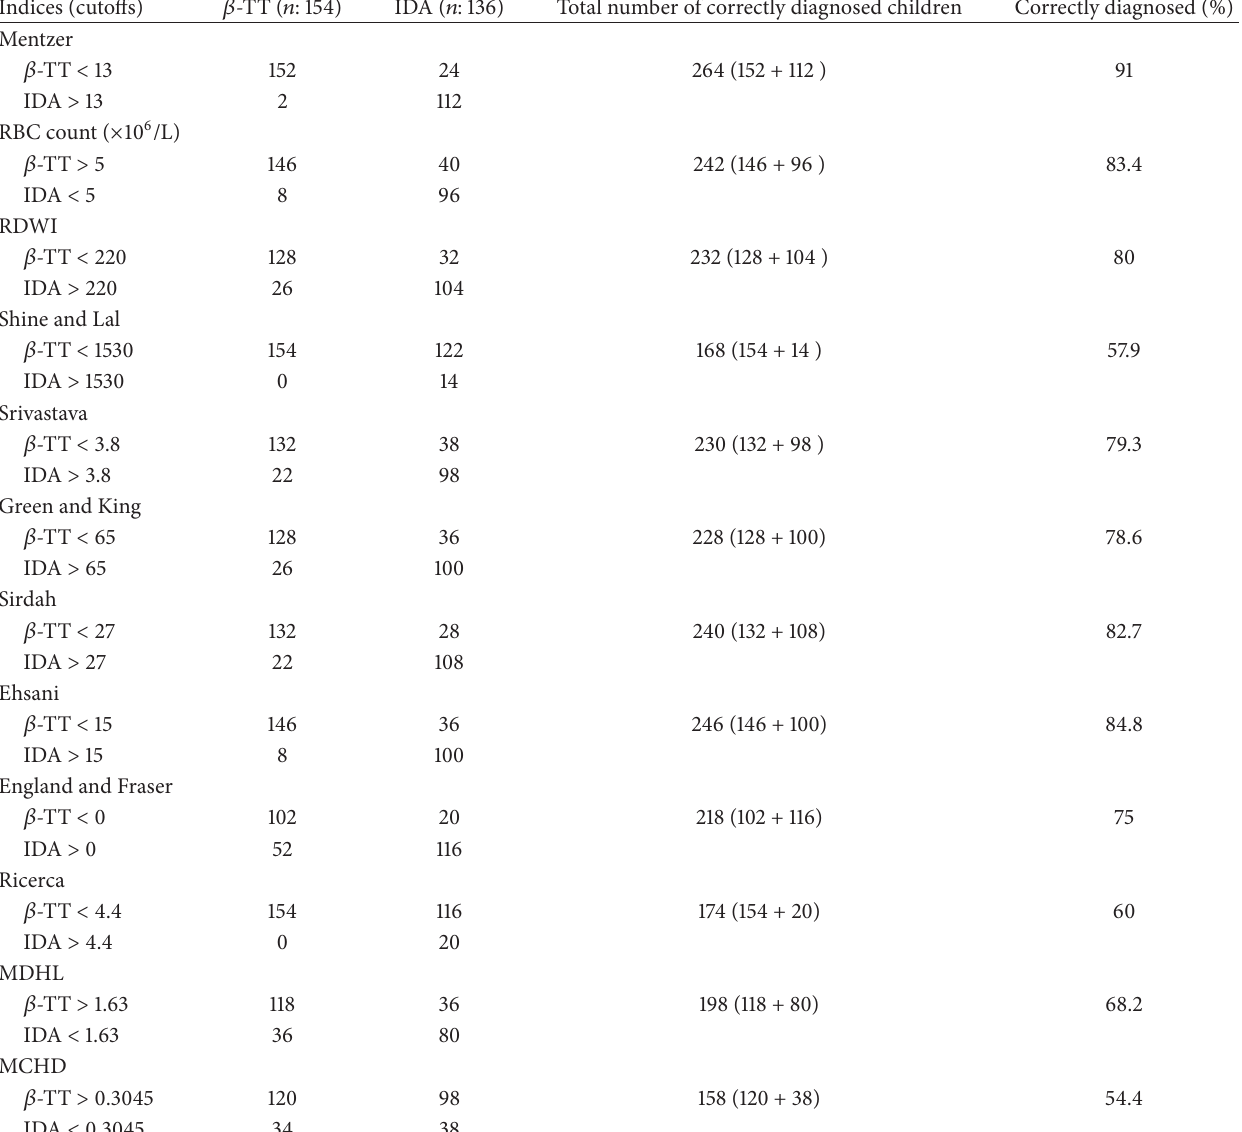
Table 3: Results obtained from each discrimination index and correctly identified number of the